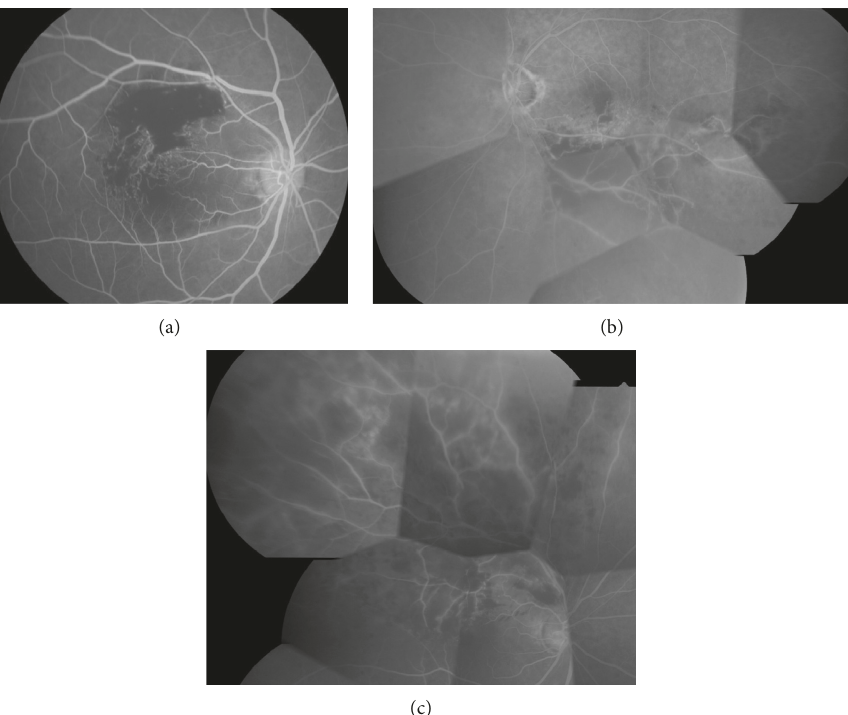
Figure 2: Vitreous fluid VEGF level and retinal nonperfusion in representative cases. Fluorescein angiograms. (a) Mild ischemia (15.6pg/ ml). The VEGF level is often 30–40pg/ml in patients with mild nonperfusion. (b) Moderate ischemia (338 pg/ml). The VEGF level is often 300pg/ml or higher when there is moderate nonperfusion. (c) Severe ischemia (2,570 pg/ml). The VEGF is often 2000–3000pg/ml when nonperfusion is